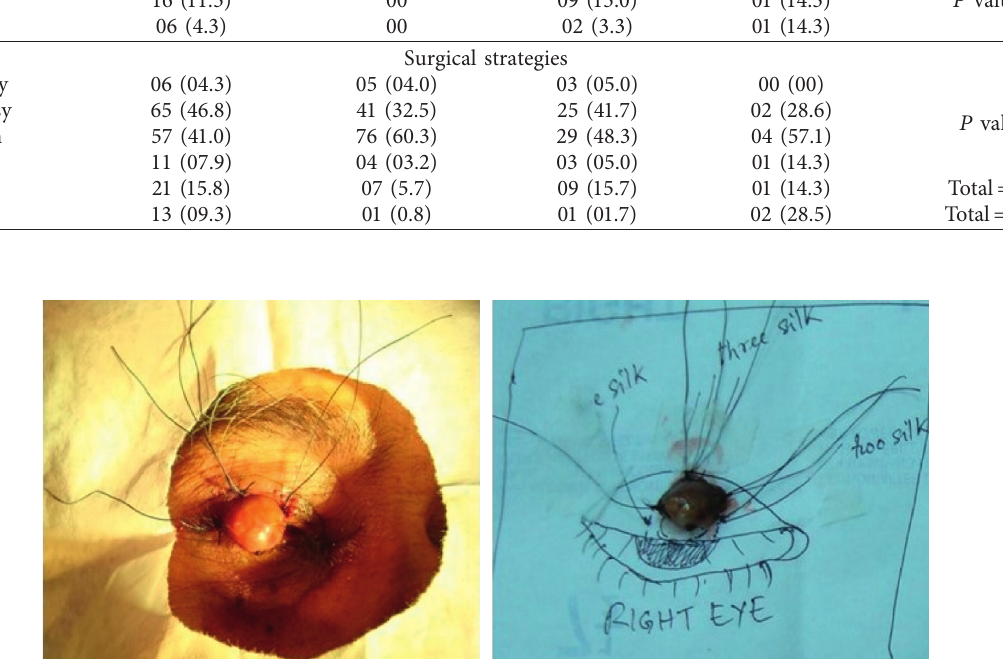
Figure 3: Frozen section biopsy procedure of sebaceous gland carcinoma of the right upper eyelid. Each margin of the excised tissue is fixed with a marker (silk suture) and the fresh tissue is sent to the pathologist for confirming the margin